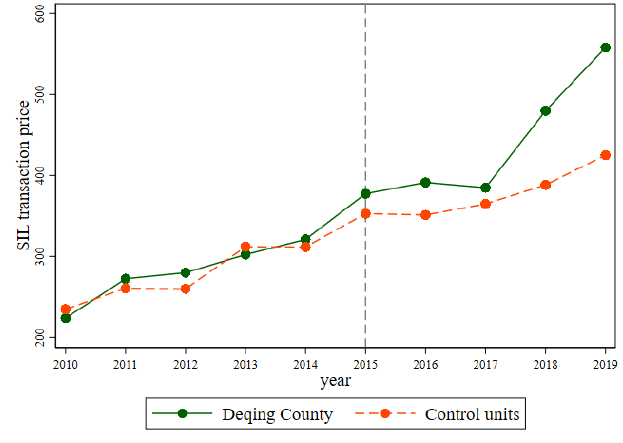
Figure 4. Trends of land transaction price: towns in Deqing County vs. the other towns of Huzhou City. Notes: The vertical line denotes the year when the trial of COCLEM was implemented.